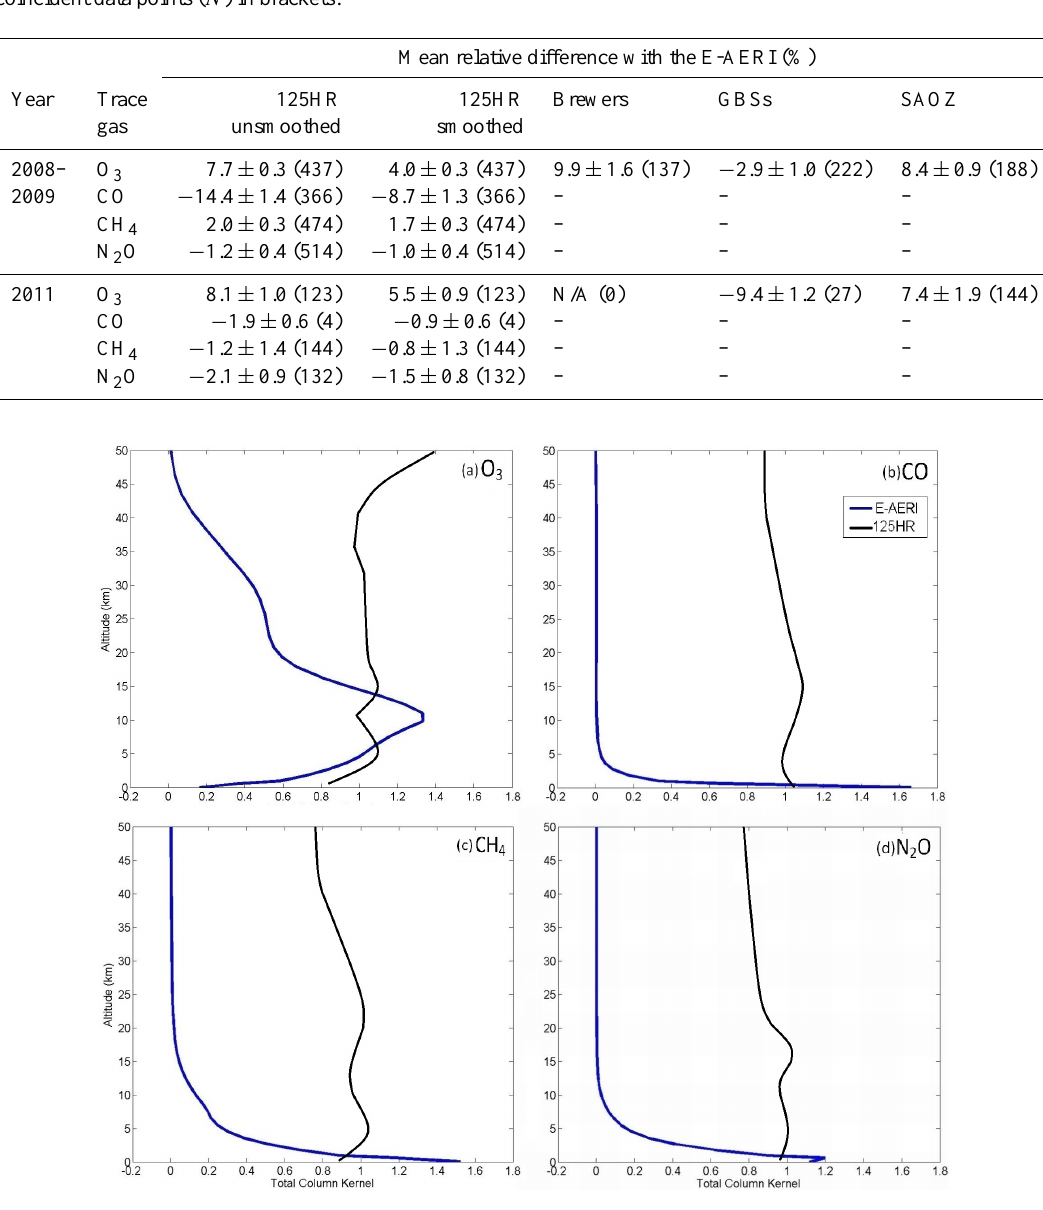
Table 3. O 3 , CO, CH 4 , and N 2 O total column comparisons between the E-AERI and the 125HR (both unsmoothed and smoothed by the monthly E-AERI averaging kernels), Brewers, GBSs, and SAOZ for 2008–2009 and 2011. The Brewers, GBSs, and SAOZ cannot measure CO, CH 4 , and N 2 O. The mean relative difference (100% × [E-AERI − instrument]/mean) is given with the standard error ( σ / number of coincident data points ( N ) in brackets.